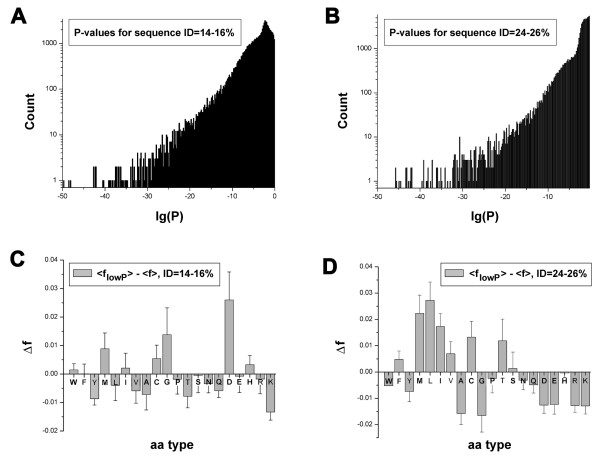
Detection of structurally aligned protein positions that correspond to dissimilar profile positions. (A, B) Histograms of P-values for FSSP alignments between domains of different sequence identity (log-log scale): A. Sequence identity 15 ± 1%. B. Sequence identity 25 ± 1%. (C, D) Difference of residue frequencies at alignment positions with lowest P-values and the whole population: C. Sequence identity 15 ± 1%, P < 10-14 . D. Sequence identity 25 ± 1%, P < 10-18.